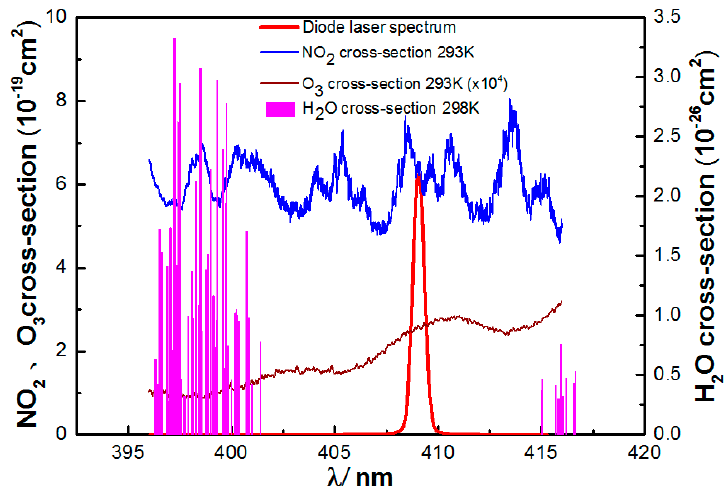
Figure 2. Absorption cross − section of NO 2 , O 3 , and water vapor and typical diode laser spectrum.